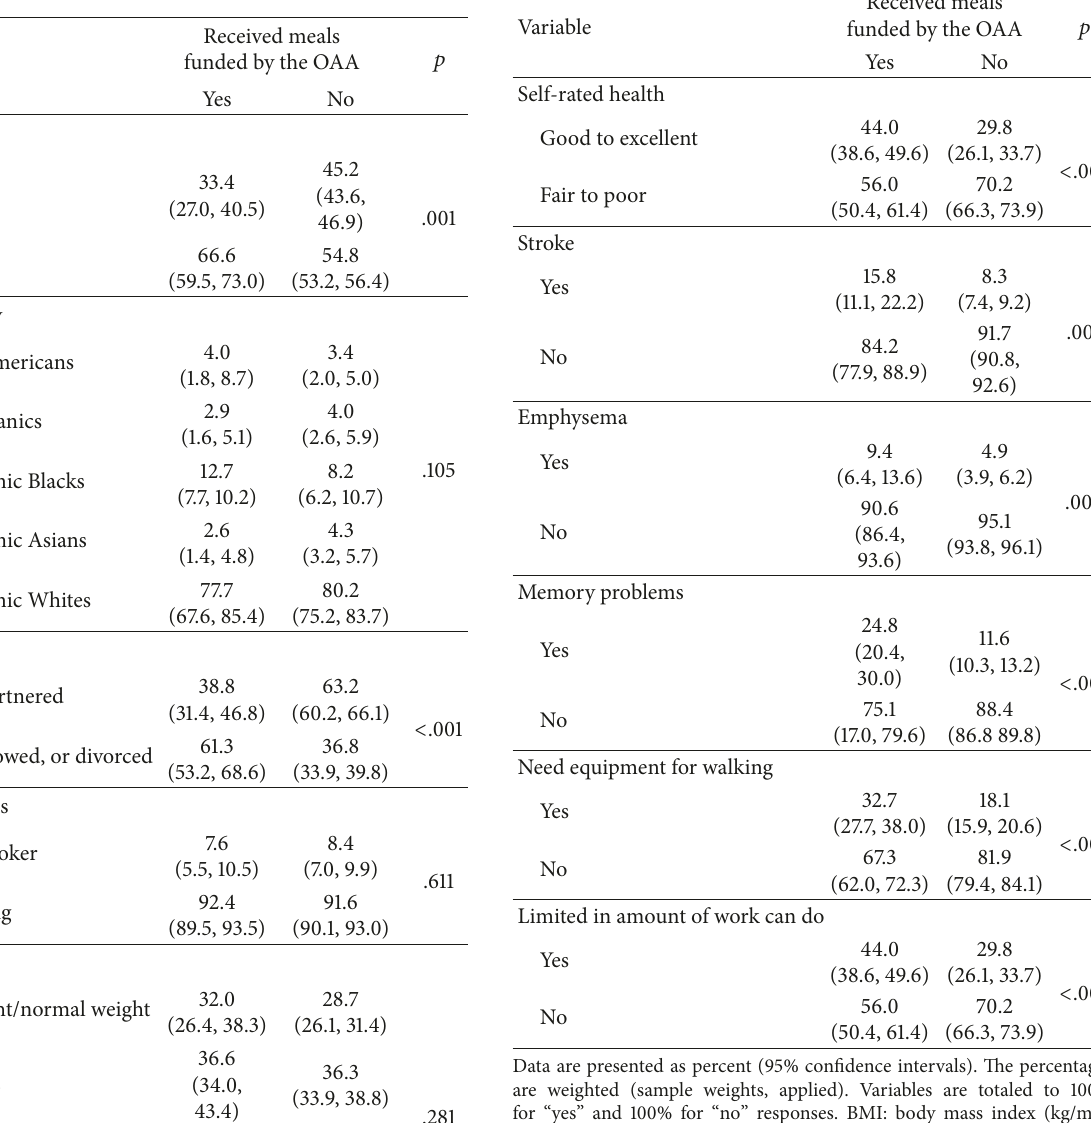
Table 2: Comparison between participants who received and did not receive meals funded by the Older Americans Act